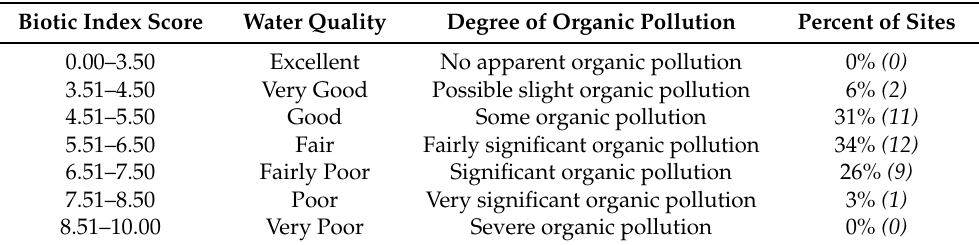
Table 1. Biotic index scores and associated water quality in the Qu’Appelle River [38,39]. Far right column displays results from the 35 Qu’Appelle River sampling